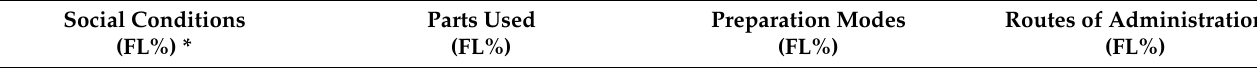
Table 4. Diversity of uses, parts, preparations, and routes of administration for H. indicum , A. mexicana